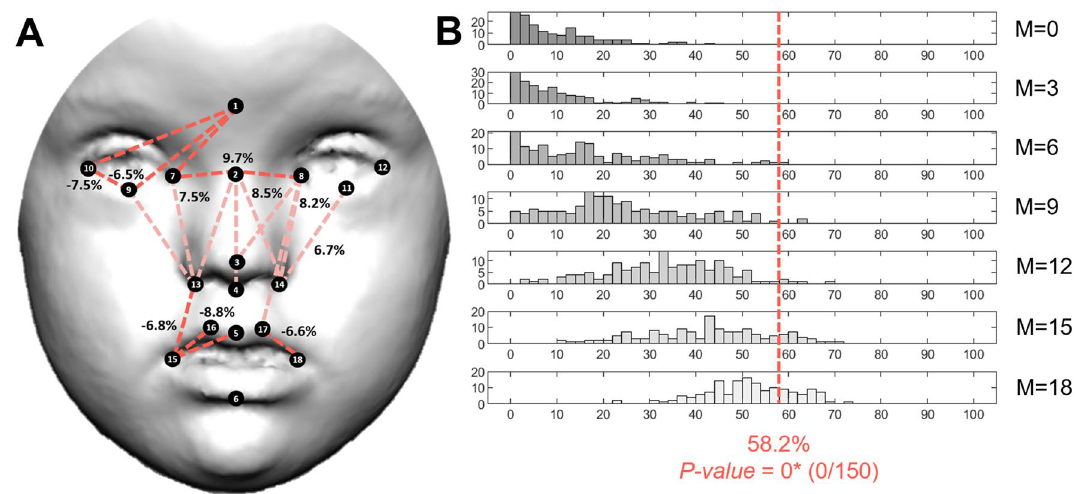
Figure 2. Localized Euclidean Distance Matrix Analysis facial shape pairwise contrasts and iterative bootstrapping tests of facial dysmorphology between controls and individuals diagnosed with Down syndrome. ( A ) EDMA results. Dotted lines represent facial measurements significantly different in control and patient groups. Lines in light tones indicate measurements that are shorter in patients as compared to controls, whereas lines in dark tones represent measurements that are longer in patients. ( B ) Iterative bootstrapping tests based on facial dysmorphology scores (FDS). Histograms represent the simulation results for each random group separately, which contain an increasing number of patients, from no patients (M = 0) to all patients (M = N). From top to bottom histograms, the simulations included 0, 3, 6, 9, 12, 15 and 18 patients. The dotted red line shows the FDS score obtained with the complete sample of control and patients (Table 1). * Statistically significant P -value.